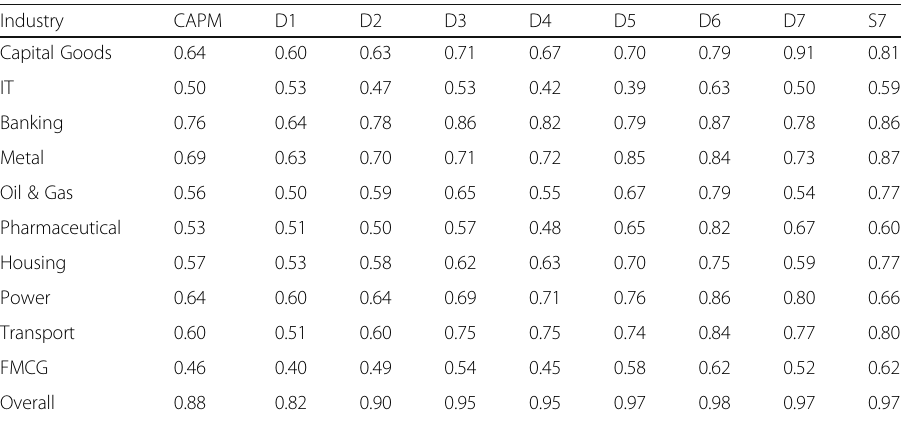
Table 2 Corresponding wavelet